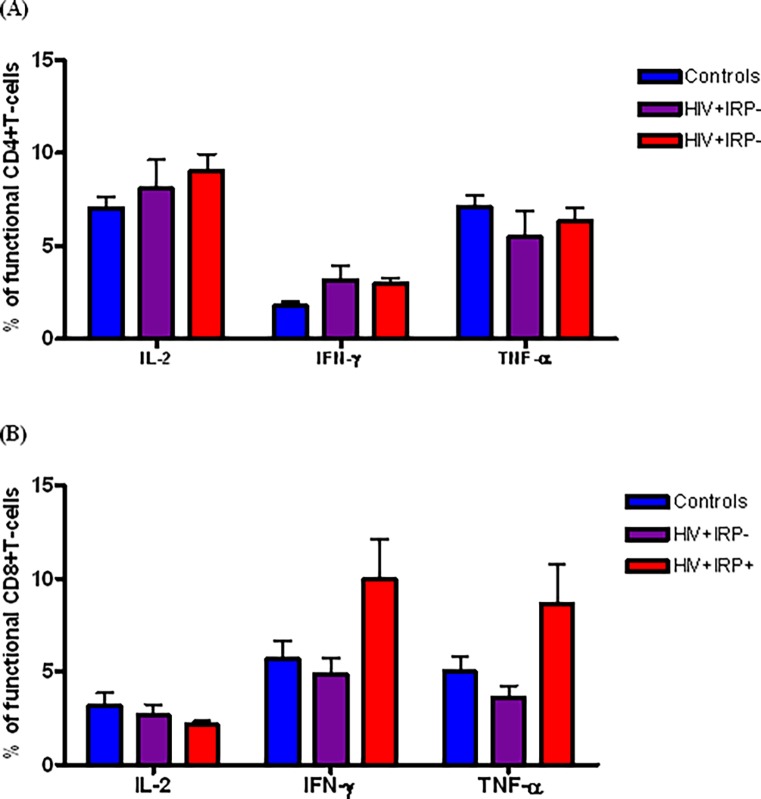
Relationship between the Immune Risk Phenotype (IRP) and Staphylococcus Enterotoxin B induced pro-inflammatory cytokine secretion.Percentages of IL-2, IFN-γ or TNF-α producing T-cells in response to Staphylococcus Enterotoxin B (SEB) stimulation within the CD4+ (A) and CD8+ (B) T-cell compartments. Comparisons were made between uninfected controls (blue), HIV+IRP+ (purple) and HIV+IRP+ (red) subjects. Statistical significance was determined using the Mann–Whitney U test. *p<0.05, **p<0.01, ***p <0.001.